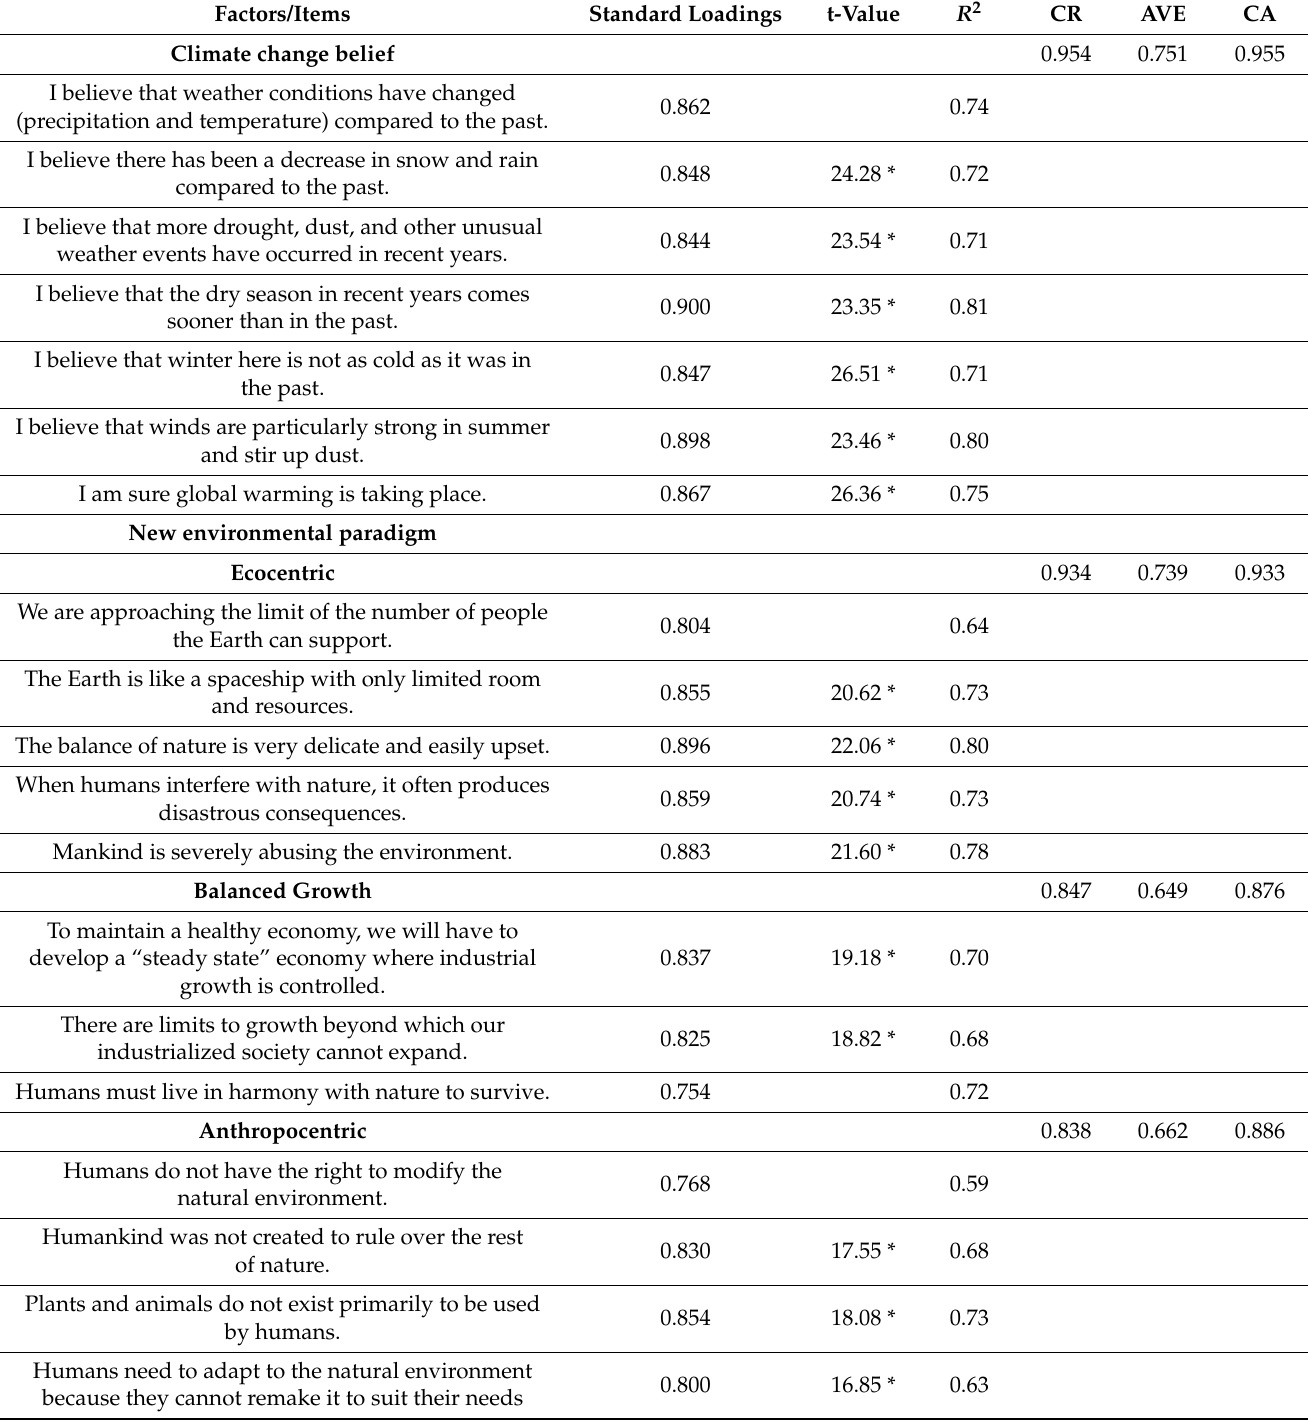
Table 4. Structural model confirmatory factor analysis